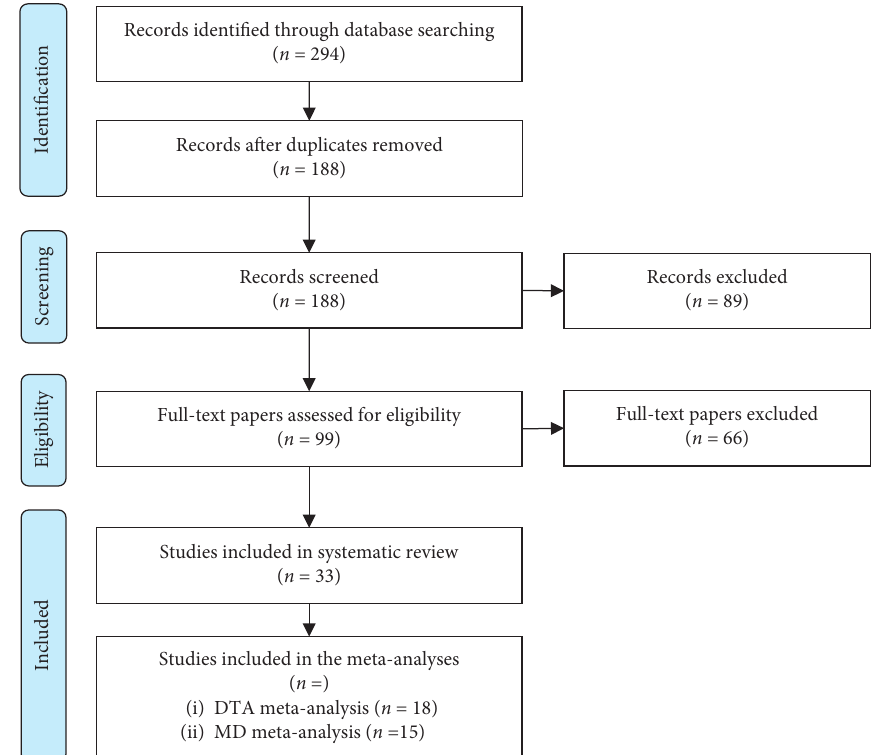
Figure 1: Study selection flowchart. DTA: diagnostic test accuracy; MD: mean